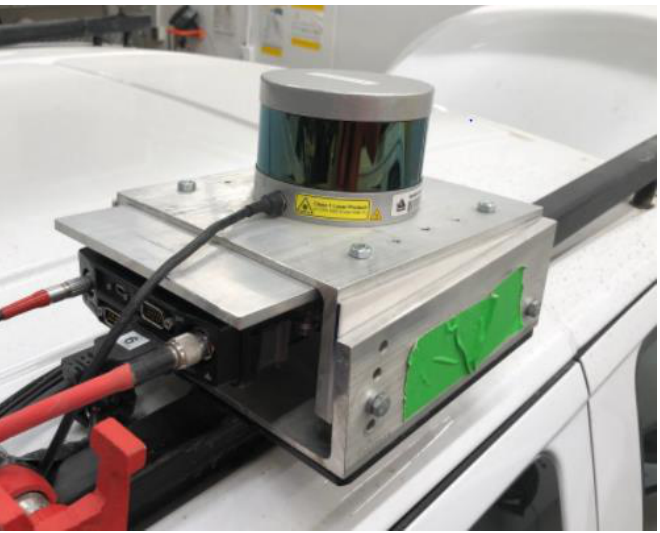
Figure 4. Mobile mapping system setup for the experimental testing.